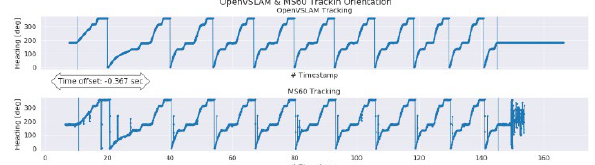
Figure 8. Time offset between relative orientation estimation (top) and prism tracking (bottom)